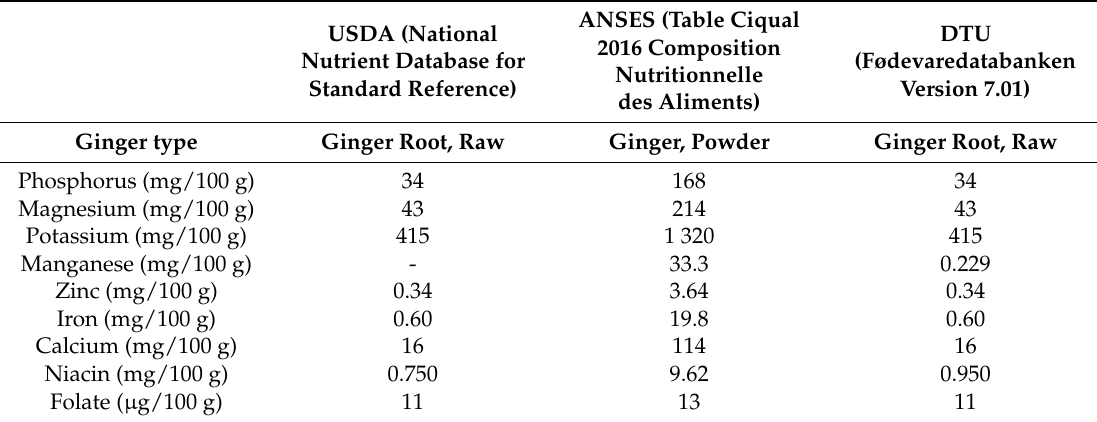
Table 3. Nutritional composition of ginger root (USDA, ANSES,